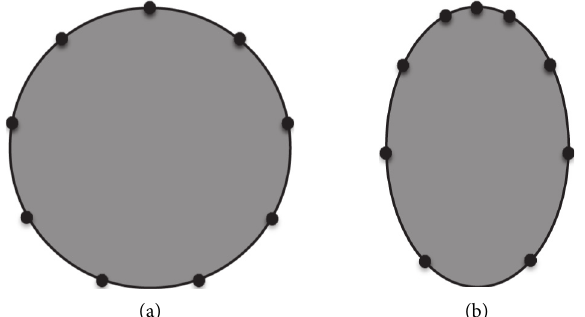
Figure 4: (a) The distribution of the P springs looks uniform from the viewpoint of the lab observer M . (b) The distribution is no longer uniform as viewed by the moving observer N . The density of the P springs’ distribution, as well as the mass density of the plate, is higher where the tangential velocity of the plate ( w ) is greater, and vice versa.